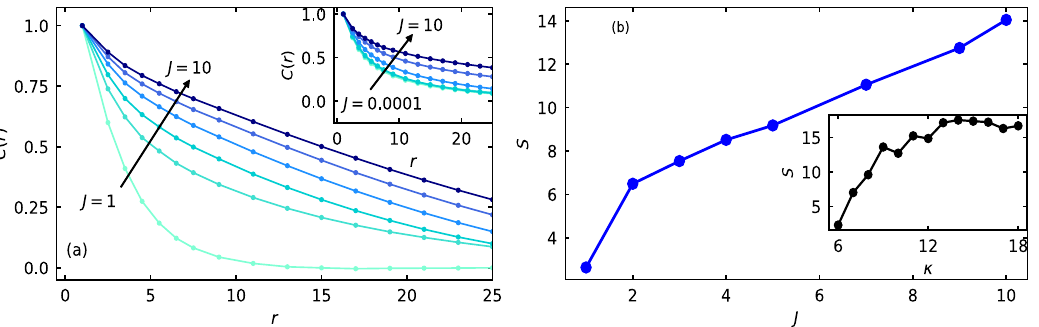
1, 10 as shown by the arrow, = [ ] 14 and for J in the range = 125 . ( b ) 0.05 and P e = = 7 . Inset shows S with variation in κ =